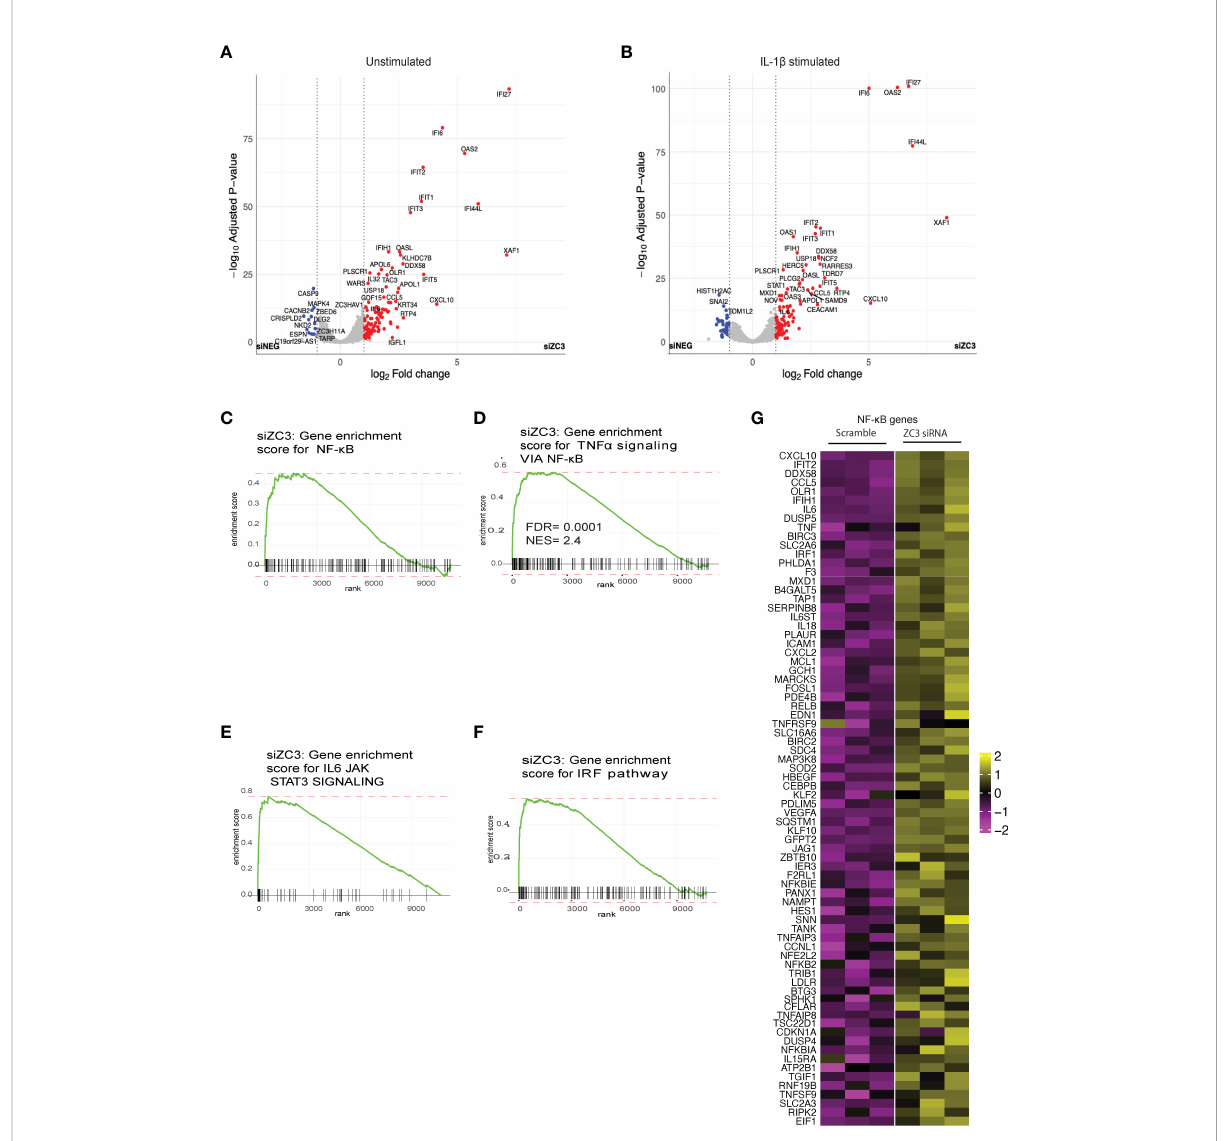
FIGURE 1 ZC3H11A is a regulator of innate immune signaling. Volcano plot analysis of the cellular mRNA expression pro fi le in unstimulated (A) and IL-1b stimulated (B) HeLa cells transfected with a ZC3H11A (siZC3) or a scrambled negative control (siNEG) siRNA. Data points represent the log2 fold-changes of the triplicate experiments (n = 3 per group). Blue, down-regulated (Padj<0.05); grey, non-regulated; red, upregulated (Padj<0.05) mRNAs. (C-F) Gene set enrichment analysis of ranked DE genes in ZC3-KD cells using hallmark gene sets. (G) Heatmap of the genes contributing to TNF-a signalling via NF-kB